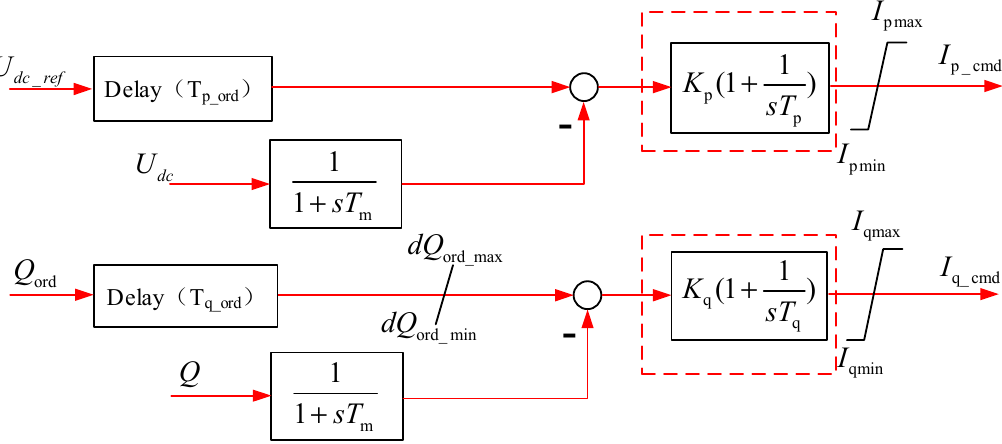
Figure 6. Control structure diagram of direct-drive wind turbine.